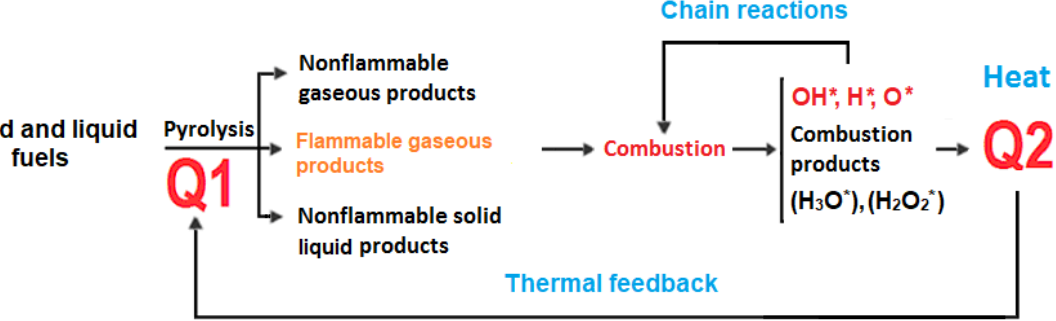
Figure 1. Scheme of combustion of solid and liquid fuels. Source: Own elaboration based on [1].